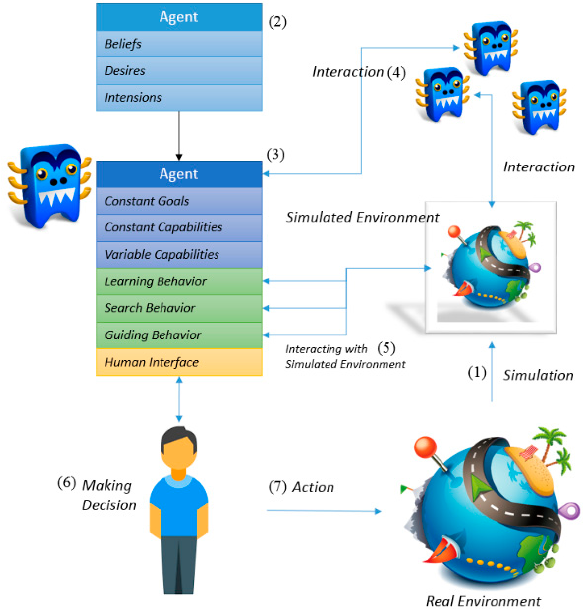
Figure 2. Structure of the proposed agent and its interactions.